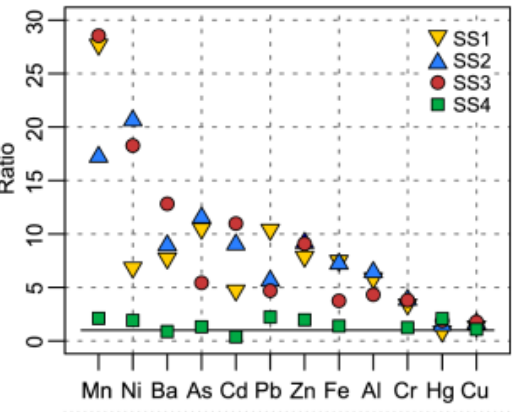
Figure 5. Ratios fresh weight concentration in Segment 5 (the most basal)/fresh weight concentration in Segment 1 (the most apical) in the shoots of F. antipyretica . The line at the bottom is at ratio = 1.